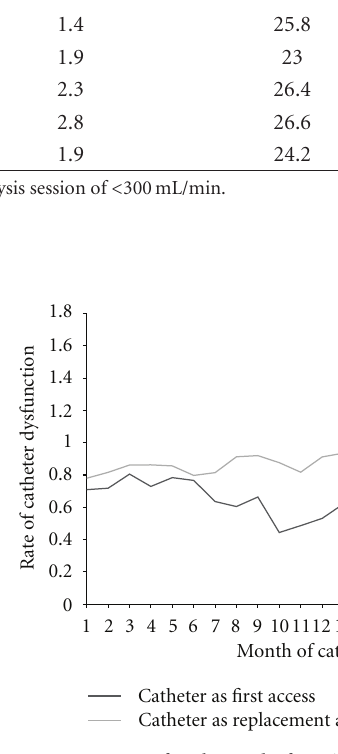
Figure 2: Time to first dialysis session with catheter dysfunction. Catheter dysfunction was defined as unplanned blood flow rate during the dialysis session of < 300 mL/min.